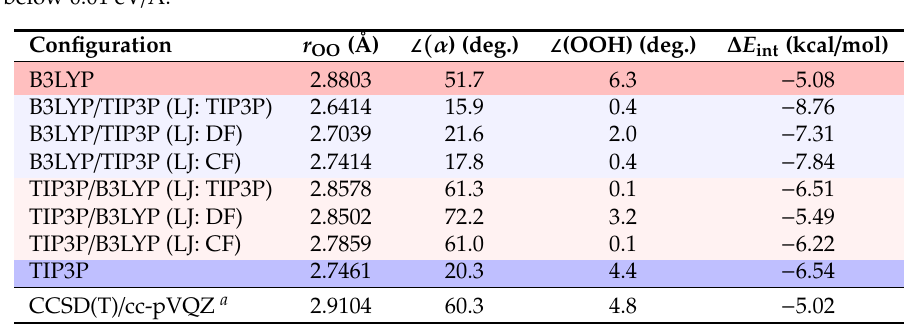
Table A1. Fully optimized geometries of the water dimer, using the various multiscale- and single-description configurations, and their corresponding interaction energies. The QM atoms were completely unconstrained while the MM atoms where constrained to the rigid TIP3P geometry. The optimizations were carried out until the maximum force component on any unconstrained atom was below 0.01 eV /